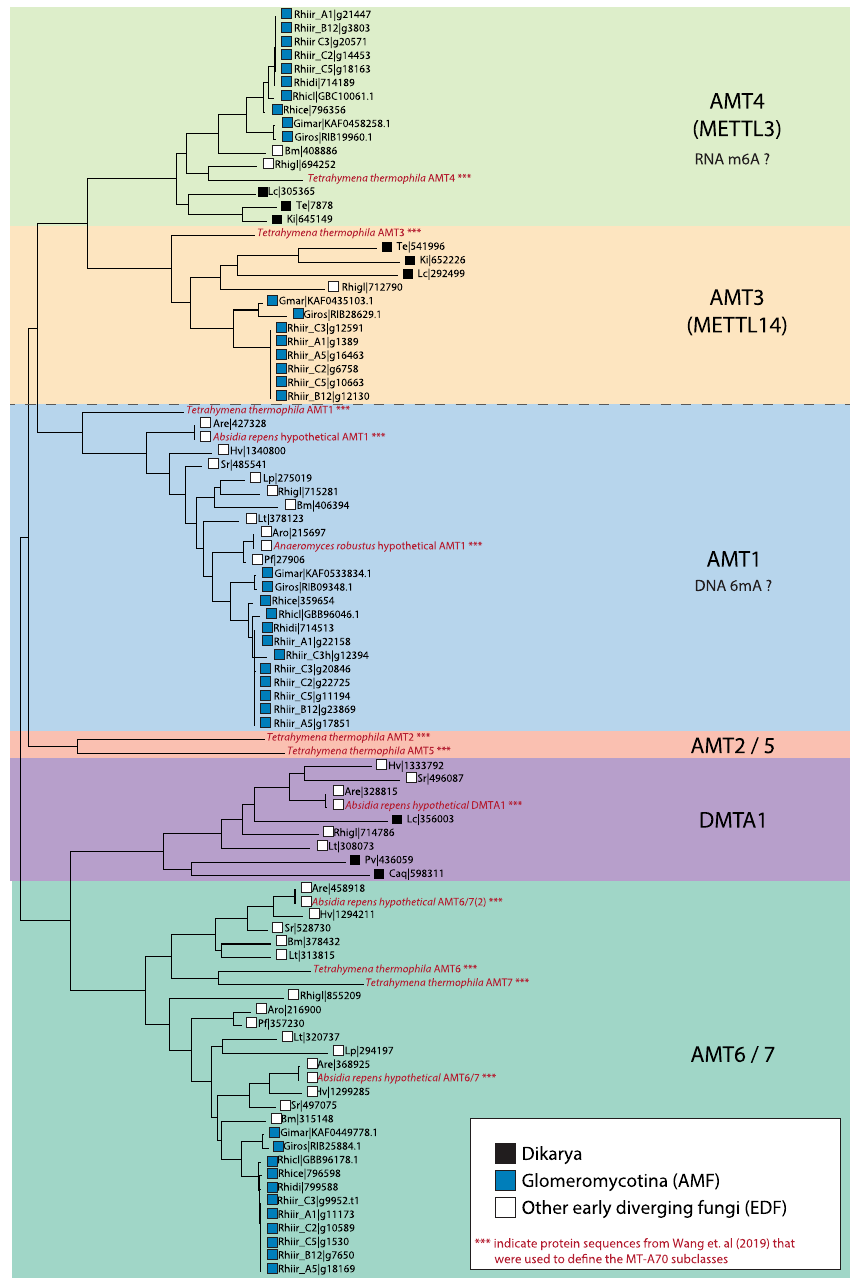
Fig. 4 Phylogenetic analysis of MT-A70 proteins across fungal taxa. Putative RNA m6A MTases (METTL3, METTL14) and putative DNA 6mA MTase subclasses (AMT2/5, AMT1, DMTA1, and AMT6/7) are separated by a dashed line. Protein sequences of T. thermophila , A. repens , and A. robustus from Wang et. al. 38 were used to de fi ne the subclasses of MT-A70 proteins. These sequences are colored in red and marked with three asterisks. Dikarya, early diverging fungi (EDF), and AMF taxa are speci fi ed with black, white, and blue squares, respectively. Species abbreviations are as follows: Clohesyomyces aquaticus (Caq); Leucosporidiella creatinivora (Lc); Protomyces lactucaedebilis : (Pl); Pseudomassariella vexata (Pv); Tremella encephala (Te); Kockovaella imperatae (Ki); Catenaria anguillulae (Can); Hesseltinella vesiculosa (Hv); Linderina pennispora (Lp); Lobosporangium transversale (Lt); Piromyces fi nnis (Pf); Syncephalastrum racemosum (Sr); Absidia repens (Are); Anaeromyces robustus (Aro); Basidiobolus meristosporus (Bm); Rhizoclosmatium globosum (Rhigl); Rhizophagus cerebiforme (Rhice); Rhizophagus clarus (Rhicl); Rhizophagus diaphanus (Rhidi); Rhizophagus irregularis isolate A1 (Rhiir_A1); Rhizophagus irregularis isolate A5 (Rhiir_A5); Rhizophagus irregularis isolate B12 (Rhiir_B12); Rhizophagus irregularis isolate C2 (Rhiir_C2); Rhizophagus irregularis isolate C3 (Rhiir_C3); Rhizophagus irregularis isolate C3 (secondary haplotig, pseudo-secondary nucleus genotype) (Rhiir_C3h); Rhizophagus irregularis isolate C5 (Rhiir_C5); Gigaspora margarita (Gimar); Gigaspora rosea